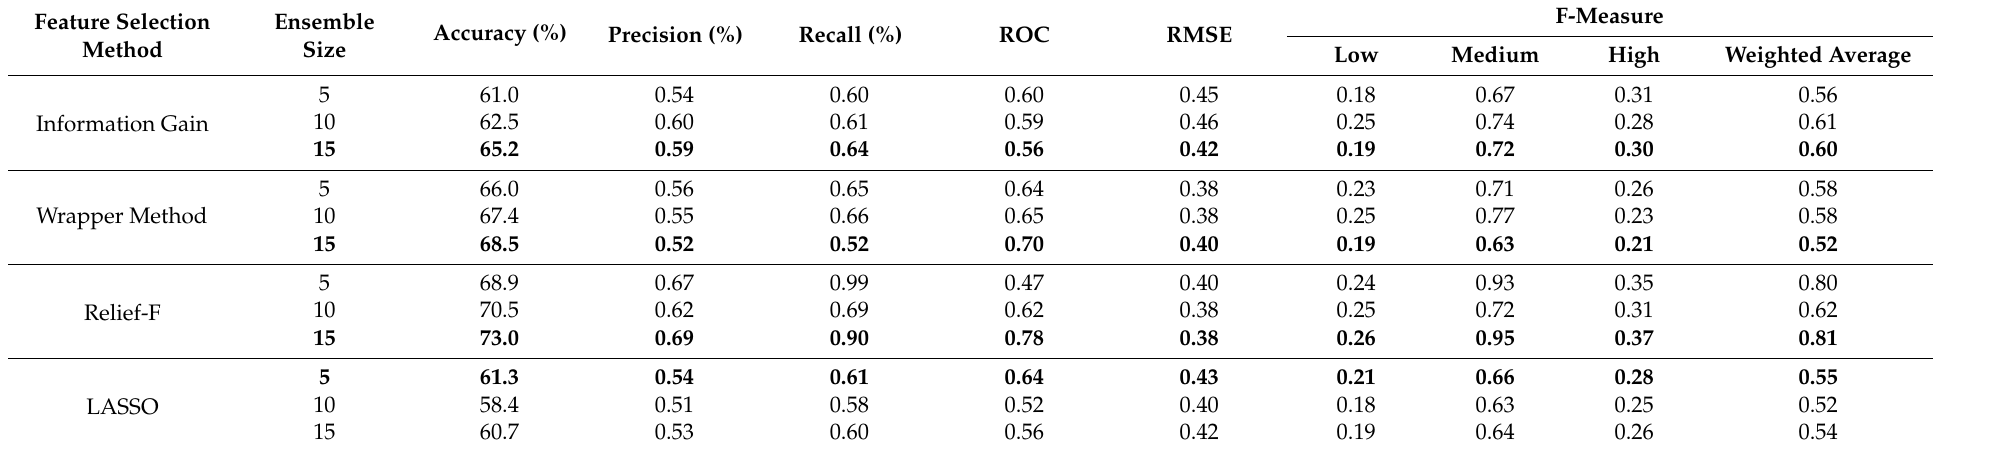
Table 7. Performance of rotation forest through various feature selection techniques.